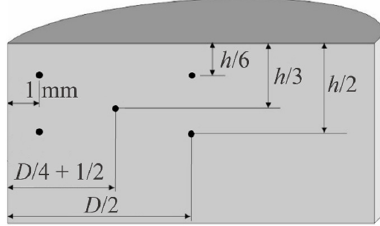
Figure 4. Microhardness indentation map on a MF-ERS compact diametrical section.